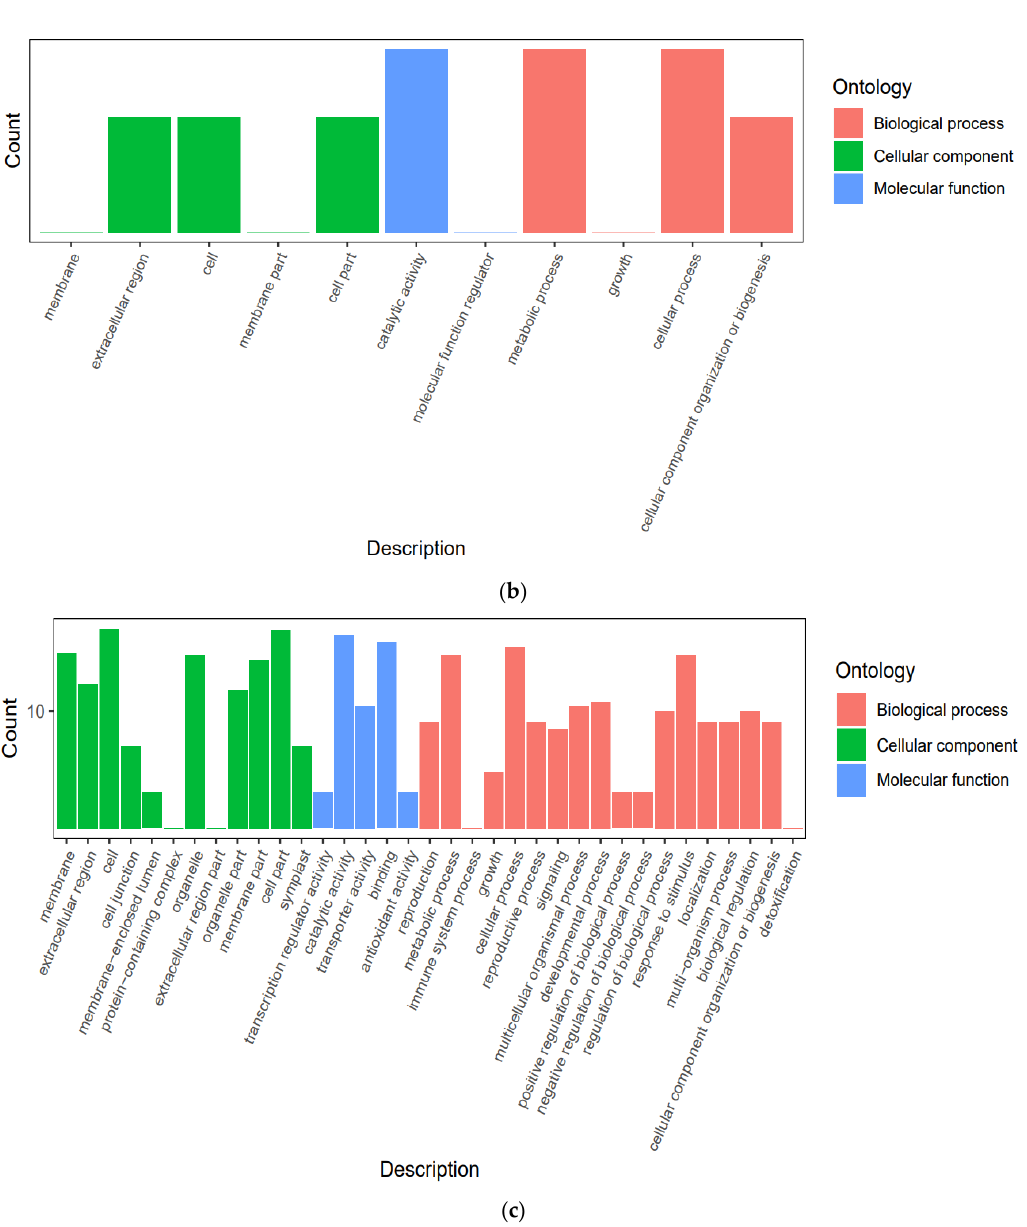
Figure 4. Statistics and functional classification of differentially expressed genes: ( a ) statistical chart of gene difference between treatment and control; ( b ) histogram of GO classification of DEGs in CK and treatment at 64 days after flowering; ( c ) histogram of GO classification of DEGs in CK and treatment at 71 days after flowering.